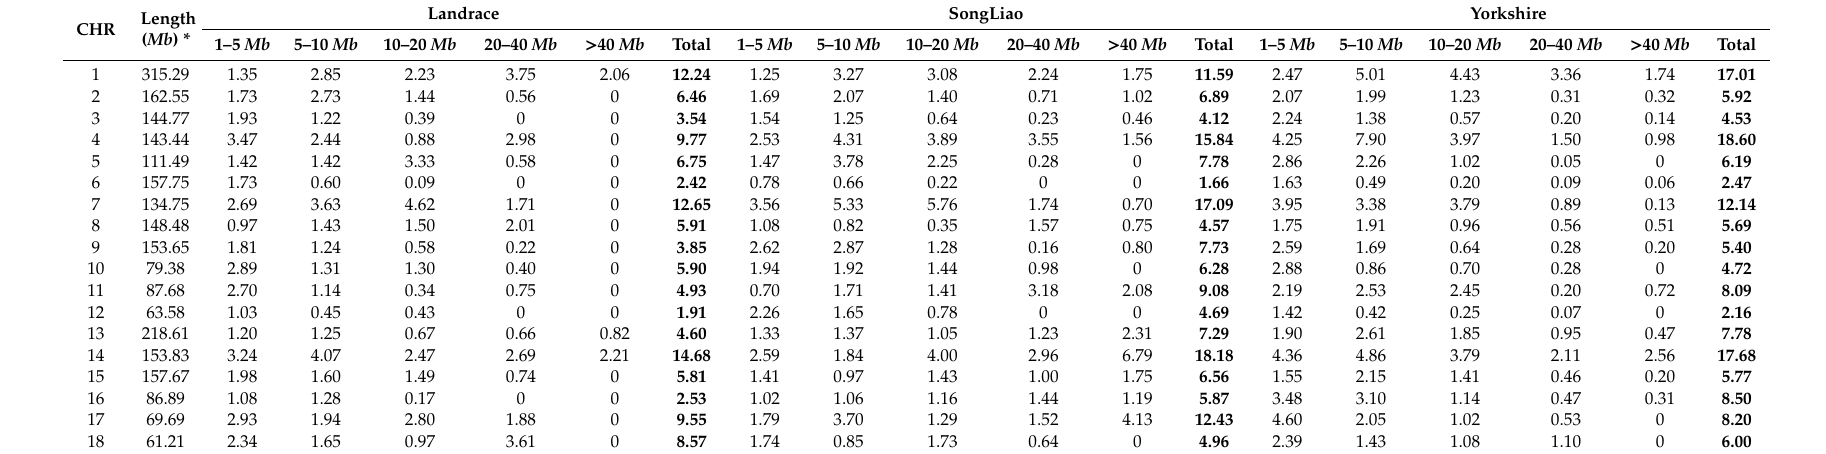
Table 3. The percentage of chromosome coverage (%) by ROH of each length classes in each